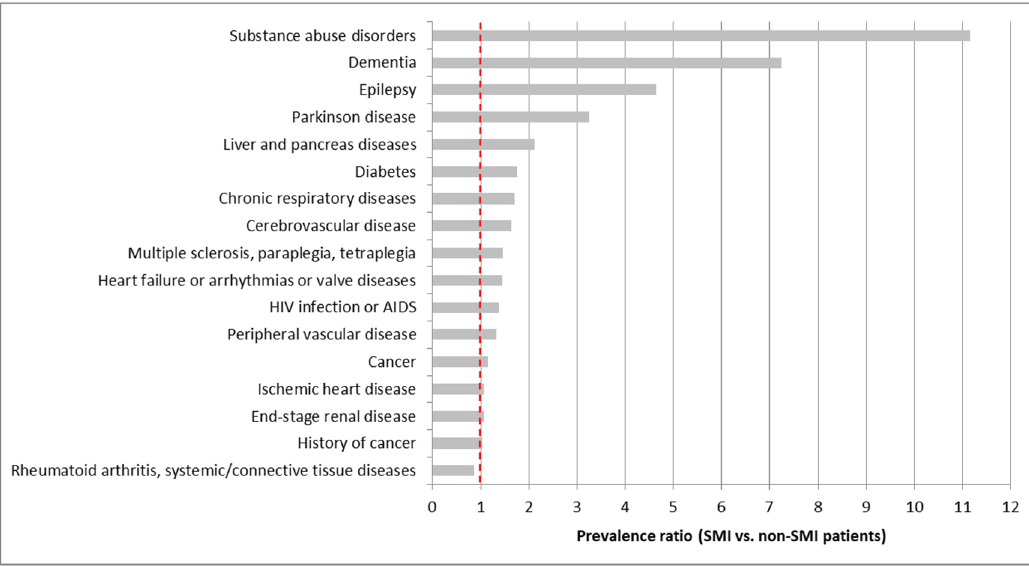
Figure 2. Prevalence ratio of main comorbidities between matched SMI patients and their controls without SMI.